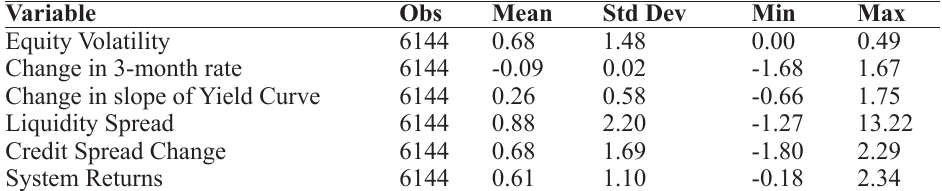
Table 2 Summary Statistics of State Variables of Financial Institutions of